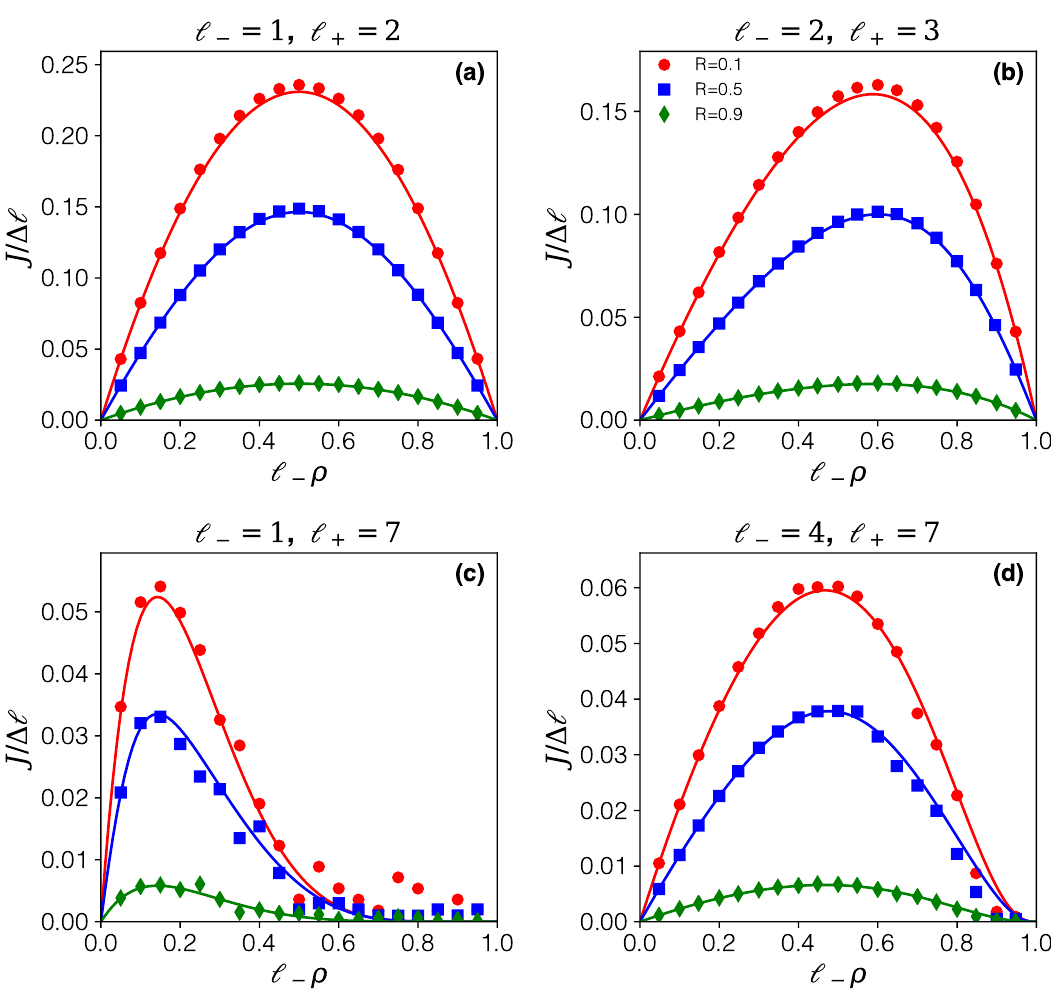
Figure 7: Current-density relation for various choices of ( (cid:96) − , (cid:96) + ) , each one contrast- ing various regimes for the expansion / compression rates ( R = 0.1,0.5,0.9). Data points are from simulations, continuous lines are predictions based on numerically solving Eq. (19). In all plots γ + =